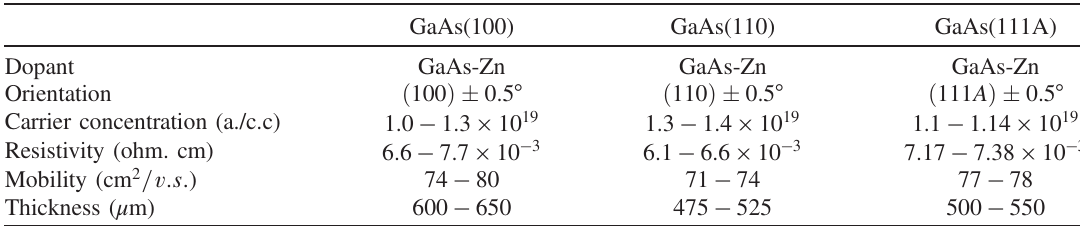
TABLE I. The specifications of three bulk GaAs samples with different surface cleave